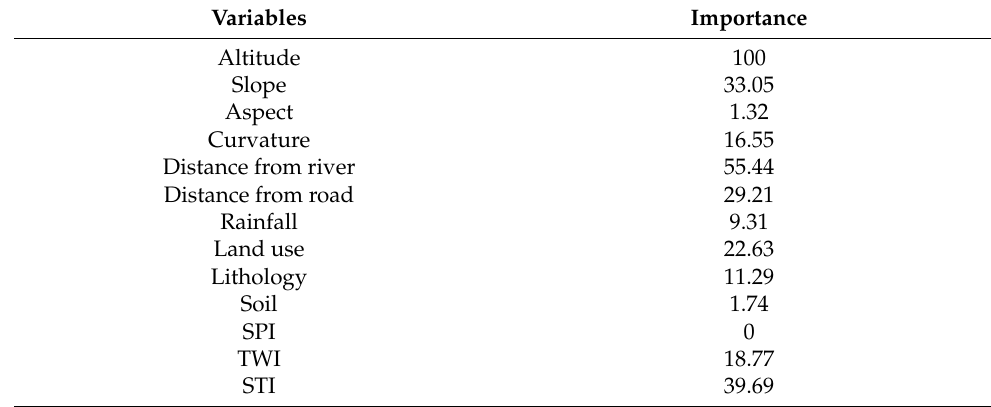
Table 7. Variable importance analysis derived from PSO-DLNN